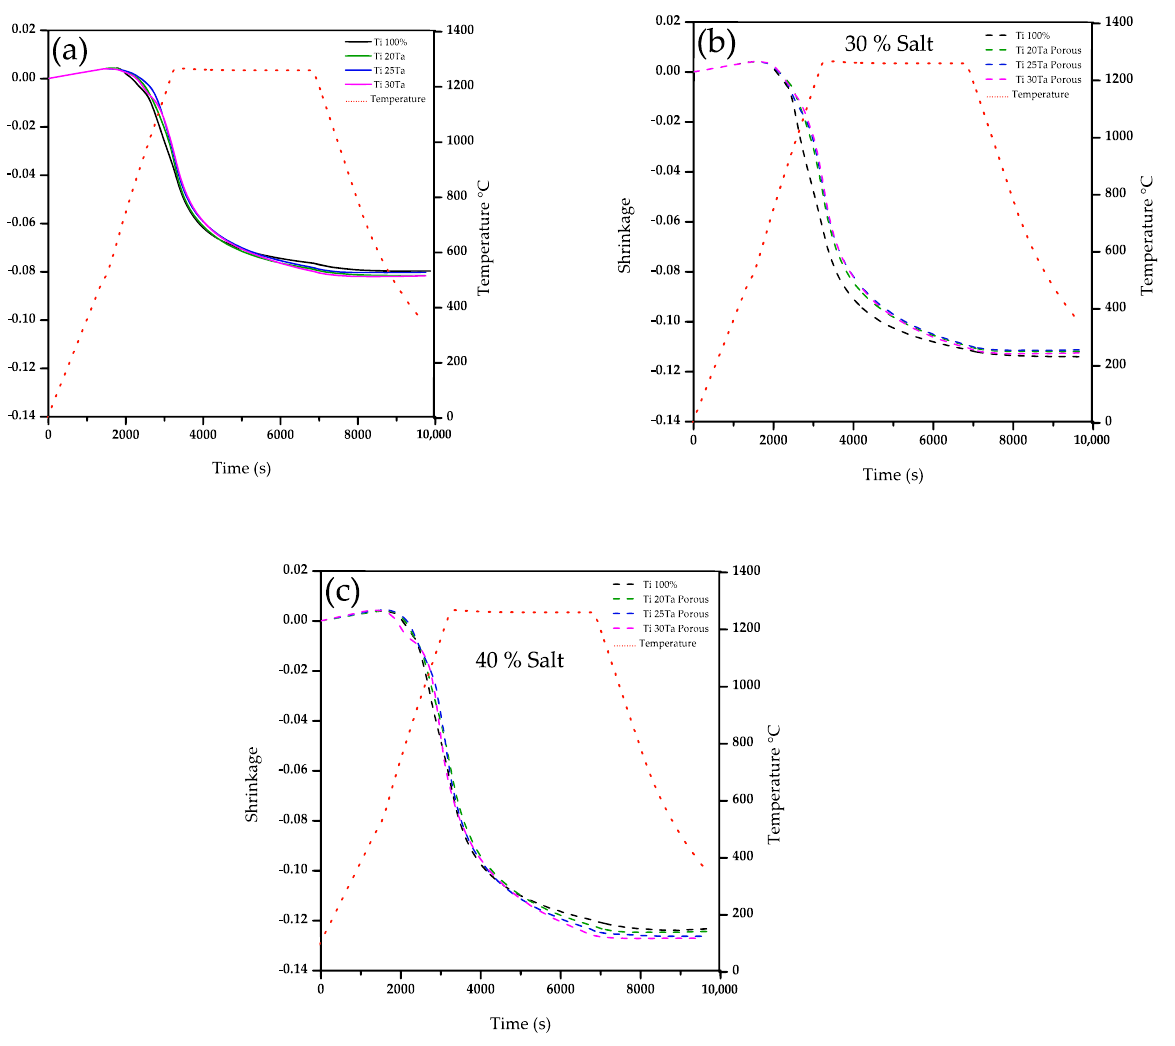
Figure 2. Strain as a function of temperature during the whole thermal cycle for ( a ) Ti-xTa samples; ( b ) Ti-xTa with 30 vol.% pore formers; and ( c ) Ti-xTa with 40 vol.% pore